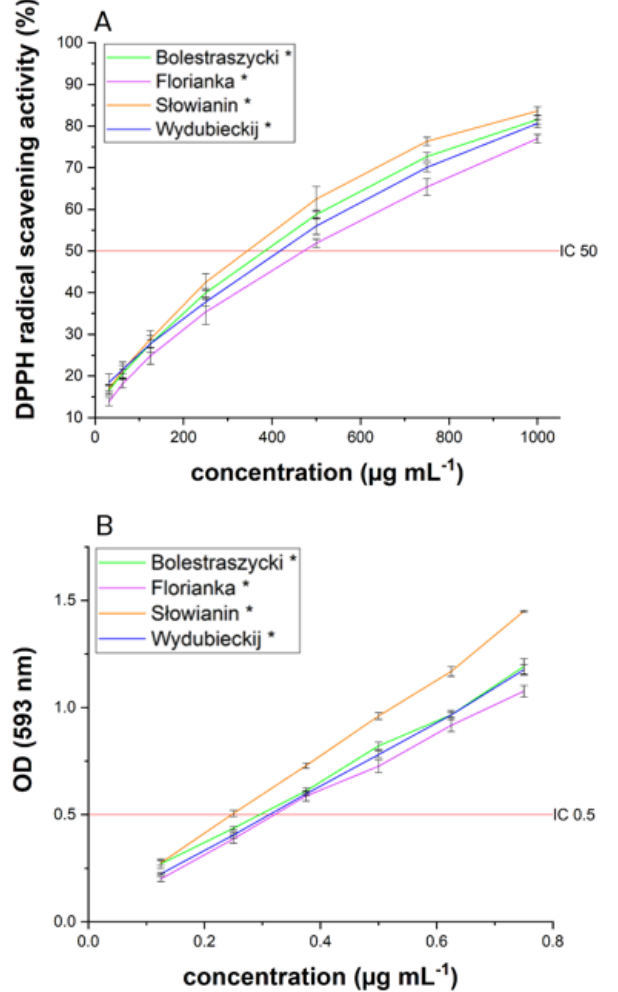
Figure 5. Antioxidant activity of Corni fructus water extracts by DPPH ( A ) and FRAP ( B ) assays. Data expressed as mean ± SD; * significance with p ≤ 0.05.